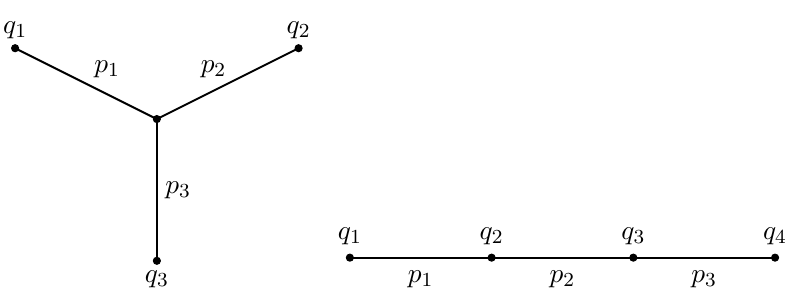
Figure 4 . The two topologies for the four-site skeleton diagrams, namely the flux capacitor (left) and the four-site chain (right). The diagram also indicates the total external energies q with each vertex A = 1 , . . . , 4 and the energy p